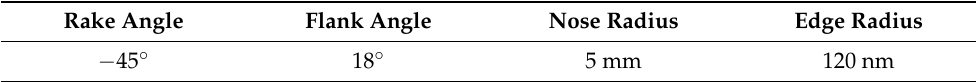
Table 4. Diamond tool parameters.